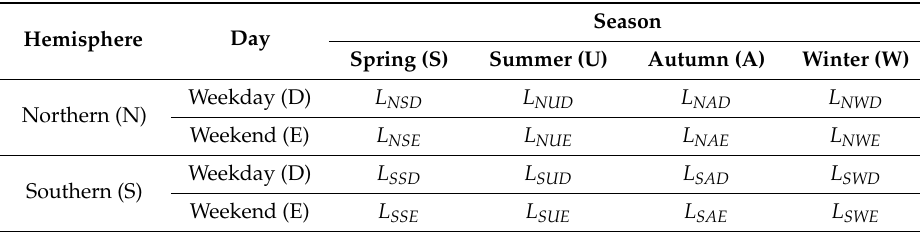
Table 4. Hourly demand